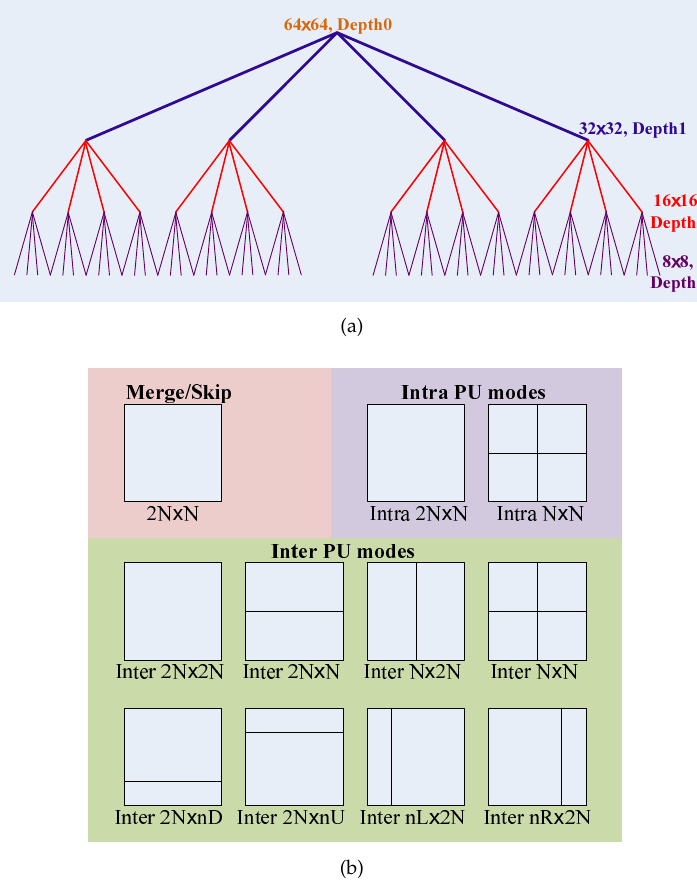
Figure 1. The quadtree-based coding units (CUs) and their prediction unit (PU) modes. ( a ) HEVC CU quadtree partition process; the maximum CU size = 64 × 64, the maximum quadtree depth = 4; ( b ) all prediction unit modes for a